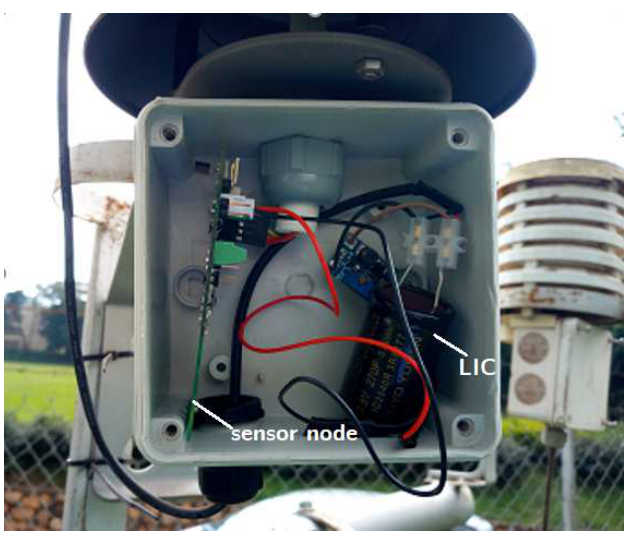
Figure 3 A wireless sensor node measuring temperature and relative humidity. It is powered by a Lithium-ion Capacitor (LIC), which is charged by a 2.5V solar panel (not shown), whose voltage is passed through a boost converter to deliver 3.8 V